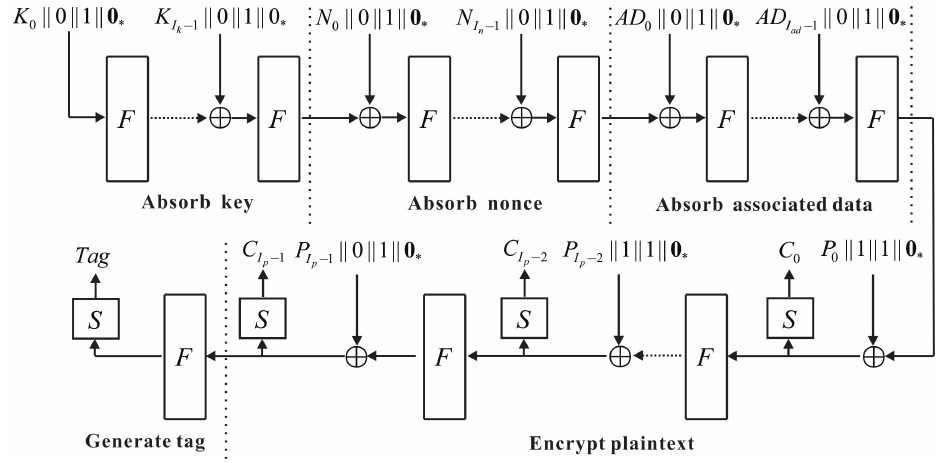
Figure 3: The encryption procedure of FRIET-AE [SBD + 20] Algorithm 2 FRIET-AE ( K, N, AD, P ) [SBD +